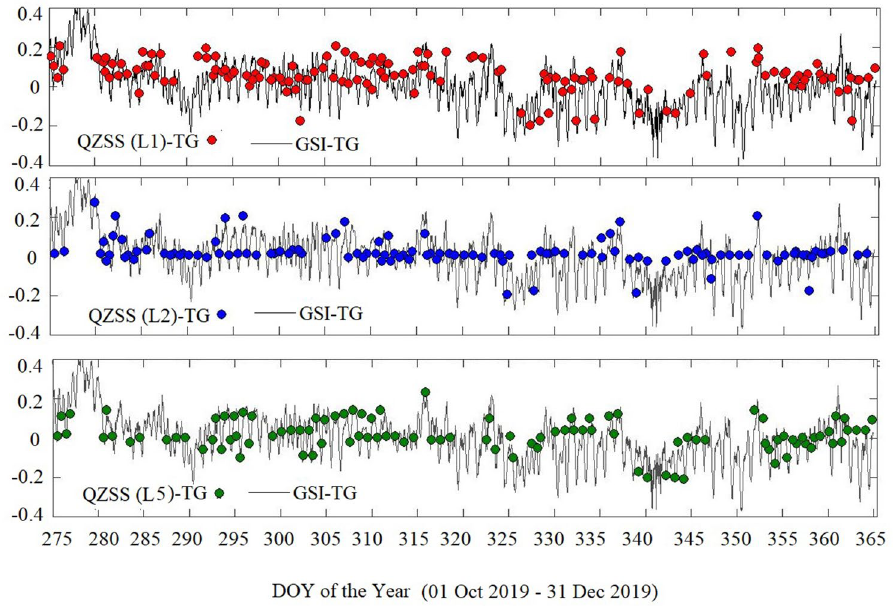
Figure 6. Daily sea-level changes (unit: m) obtained from QZSS L1, L2 and L5 SNR observations (namely, QZSS-TG) as well as GSI tide gauge (namely, GSI-TG) observations during 01 October 2019 to 31 December 2019 (90 days).